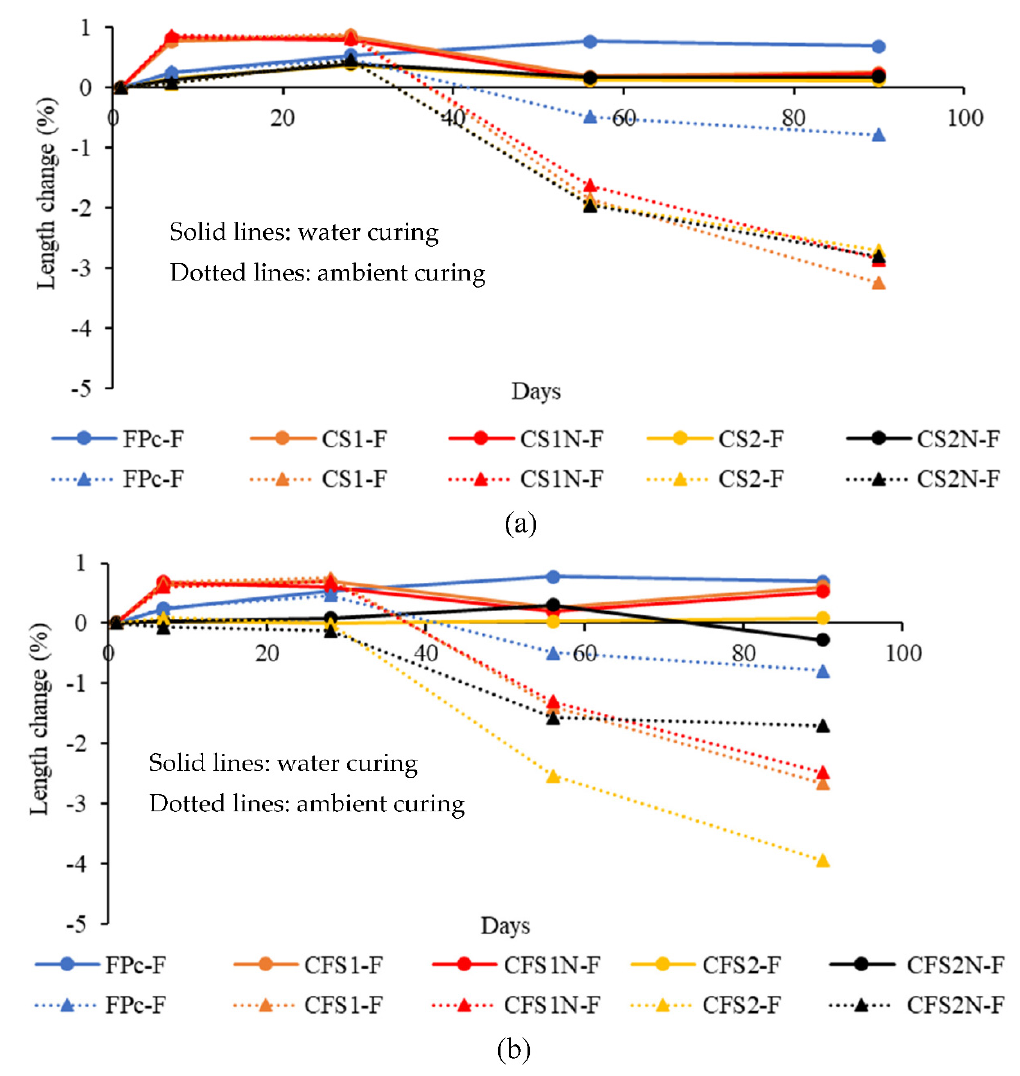
Figure 11. ( a ) Influence of binary combinations of SCMs in reinforced binders on length change. ( b ) Influence of ternary combinations of SCMs in reinforced binders on length change.